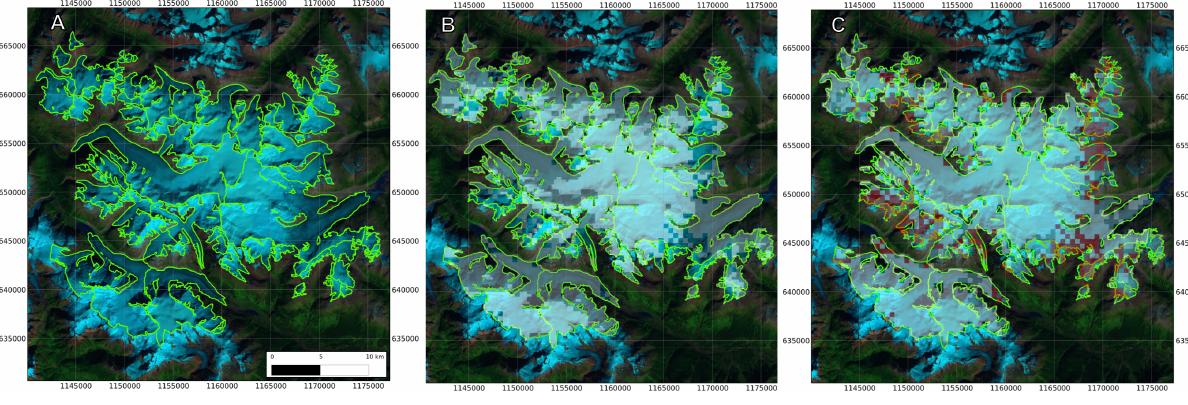
Fig. 3. (A) Landsat 5 scene of Lillooet Icefield, 5 September 2001, with (B) corresponding MOD02 snow (white) and ice (grey) clusters, and (C) MOD10 snow cover product. Cloud-obscured pixels in (C) are shown in